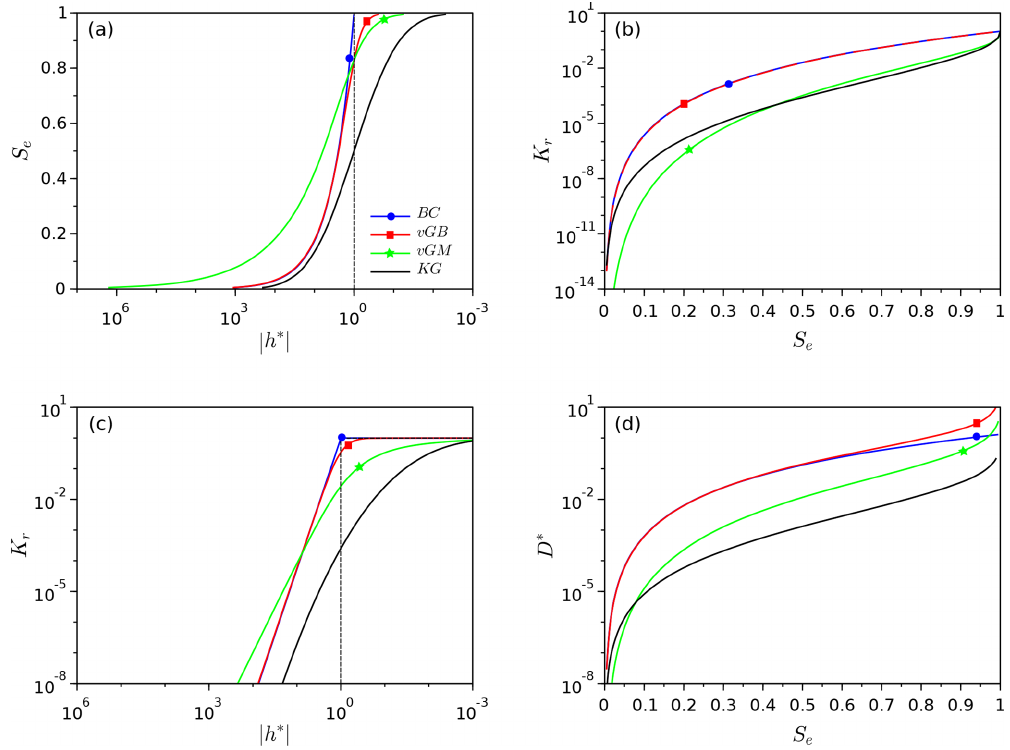
Figure 1. Examples of water retention, S e (h ∗ ) (a) , relative unsaturated hydraulic, K r (S e ) (b) and K r (h ∗ ) (c) , and diffusivity D ∗ (S e ) func- tions (d) for the four hydraulic models, Brooks and Corey (BC), van Genuchten–Burdine (vGB), van Genuchten–Mualem (vGM), and Kosugi (KG); the curves were plotted for the same value of the shape index, x = 0 . 275. The hydraulic parameters λ BC , m vGM , m vGB , and σ KG were computed as a function of x using Eq. (55) with l vGM = l KG = 1 . The dashed line represents the delta 2